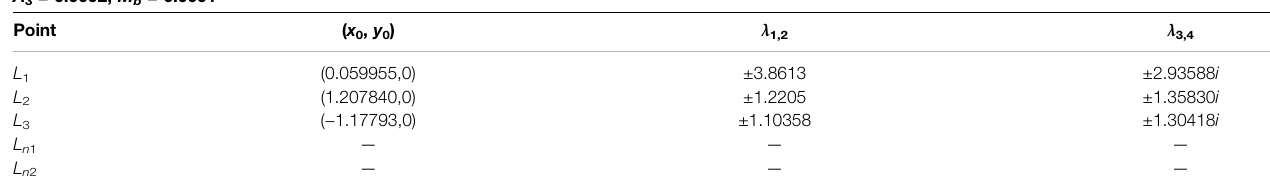
TABLE12| Locationsandeigenvalues λ 1,2 , λ 3,4 of Eq.13 intheHD155876binarysystemwithvaryingoblatenessandmassofthediscfor q 1 =0.979950, q 2 =0.983912, σ 1 = 4 × 10 − 5 , σ 2 = 3 × 10 − 5 , σ 1 ′ (cid:1) 2 × 10 − 5 , and σ 2 ′ (cid:1) 10 − 5 . A M b = 3 = 0.0002,